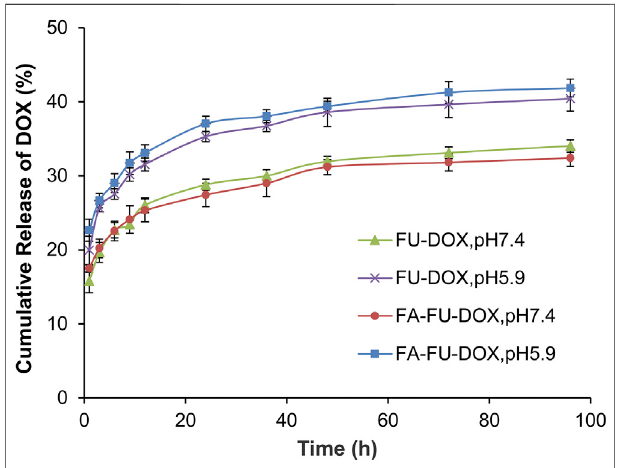
FIGURE 4 | The cumulative release kinetics of DOX from FU-DOX and FA-FU-DOX in PBS at a pH of 7.4 or 5.9 at 37 ° C.